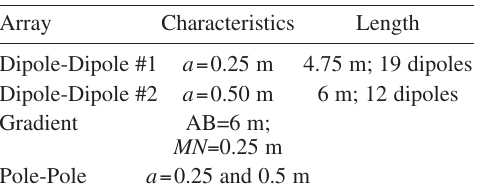
Table I. Main characteristics of surveys carried out inside the church. a – potential electrodes spacing.